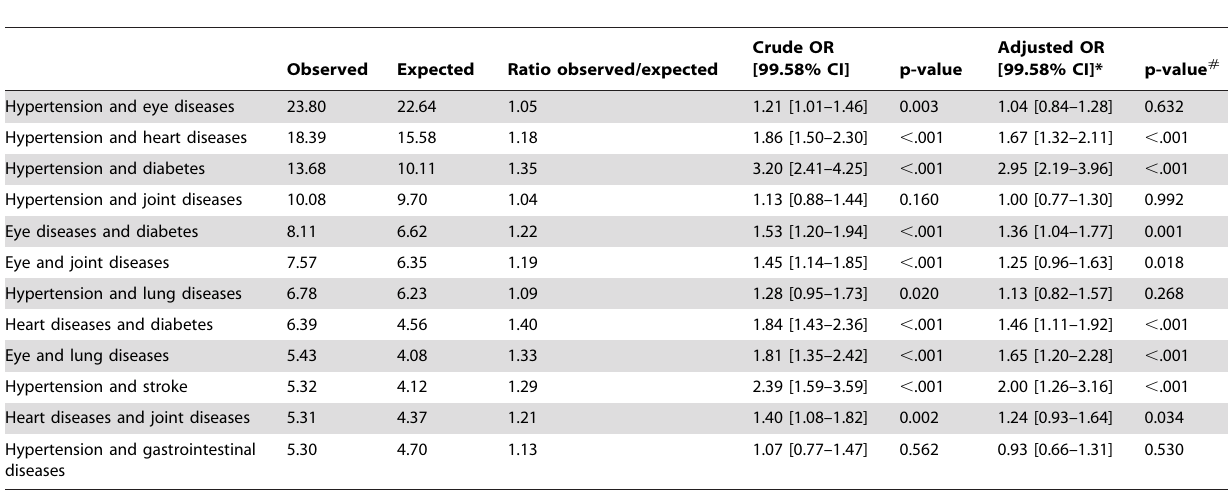
Table 4. Most frequently co-occuring pairs of conditions and their observed and expected